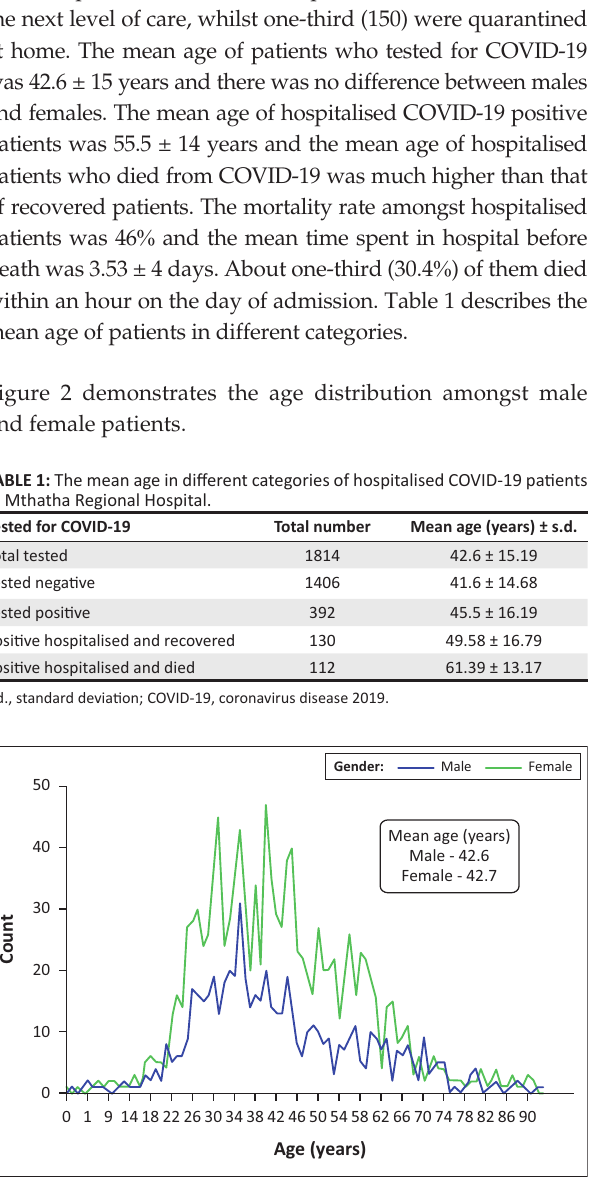
FIGURE 2: Age distribution of patients tested for COVID-19 ( n = 1814). FIGURE 3: Gender and age distribution of COVID-19 outcomes ( n = 242).